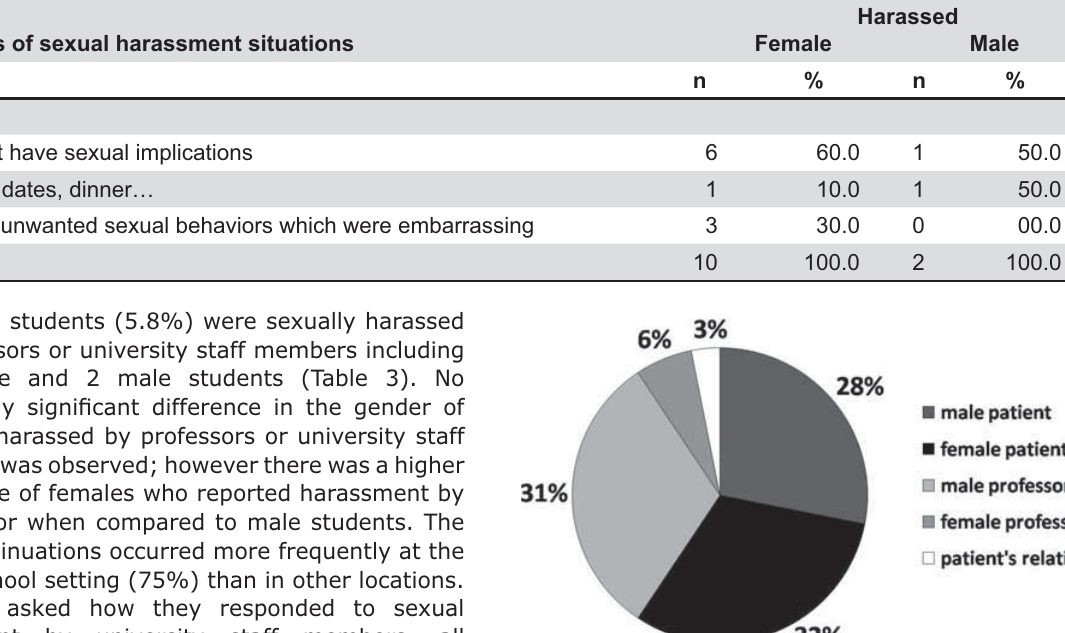
Table 3- Sexual harassment experiences reported by dental students who cited the professor or the university staff as the perpetrator